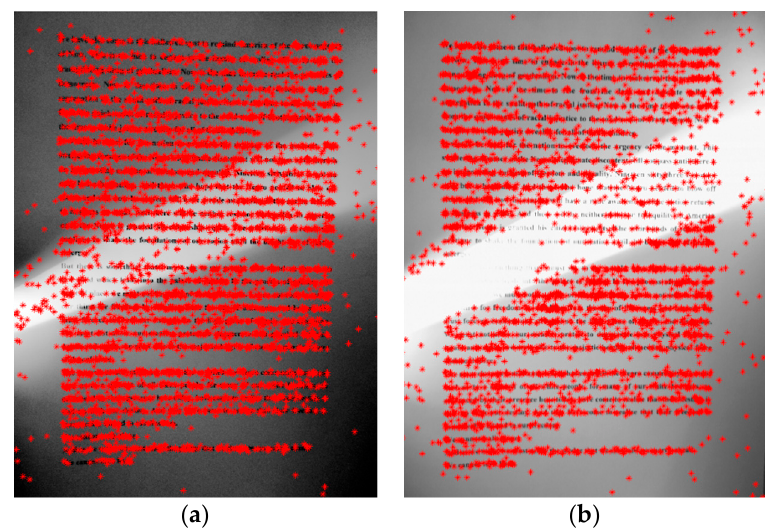
Figure 5. ( a ) Matched Scale-invariant Feature Transform (SIFT) feature points for a well-exposed image (Figure 1a); ( b ) Extracted SIFT feature points for an over-exposed image (Figure 1c).